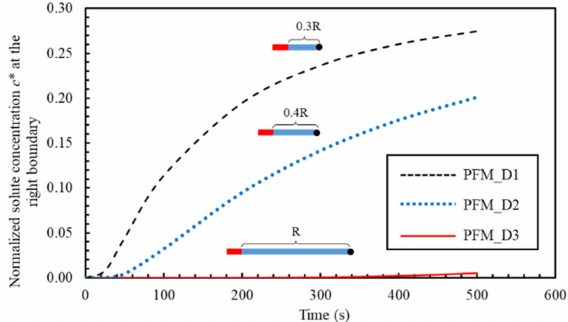
Figure 13. Change in solute at the solution boundary with